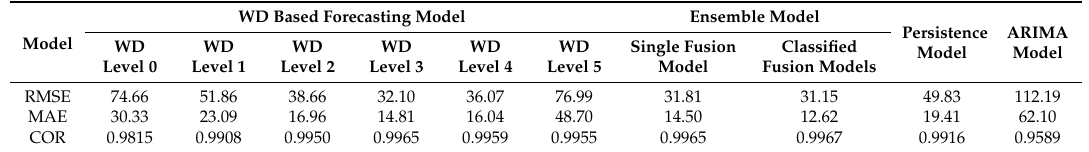
Table 2. The accuracy of different forecasting models at Desert Rock station.